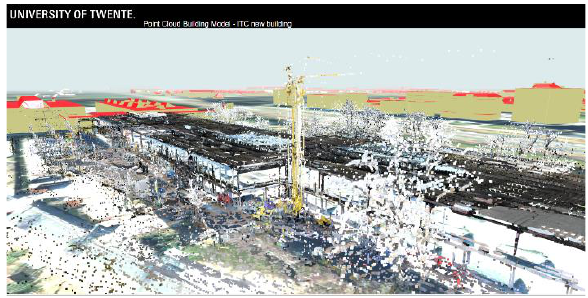
Figure 6 . The VR web navigation (PCBM model) of the new ITC building.